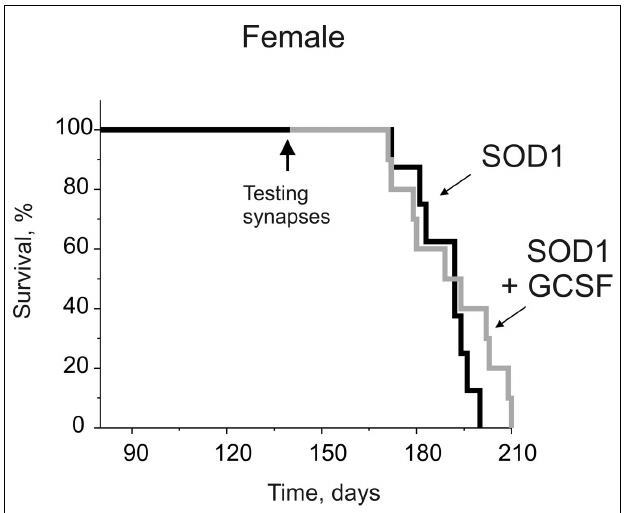
FIGURE 1 |The time course of survival for female G93A-SOD1 mice with or without GCSF treatment (Kaplan–Meier survival graph). The female G93A-SOD1 mice were treated with GCSF starting at the age of 12weeks. In contrary to the previous results we obtained from male G93A-SOD1 mice (Pollari et al., 2011), GCSF did not prolong the survival of female G93A-SOD1 mice ( n = 8–10).